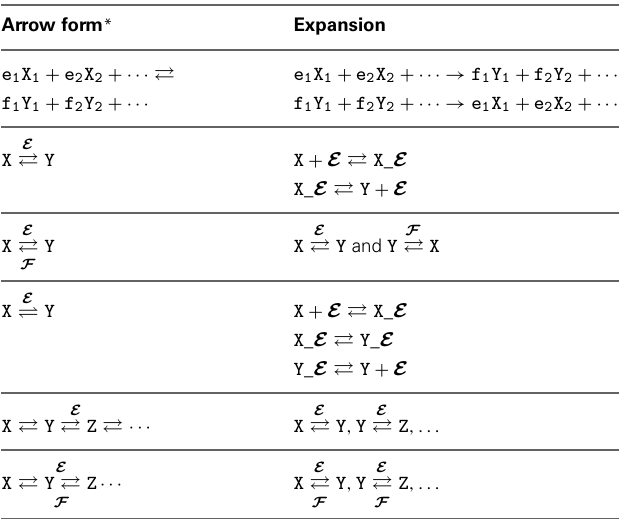
Table 1 | Examples of Cellerator mass action arrow form expansion, from the base from A → B